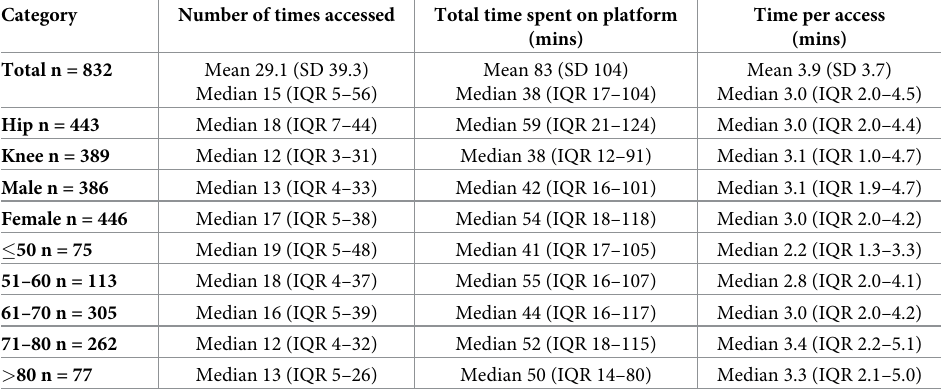
Table 2. Summary of number of accesses, time spent on the platform and time per access dependent upon type of surgery, sex and